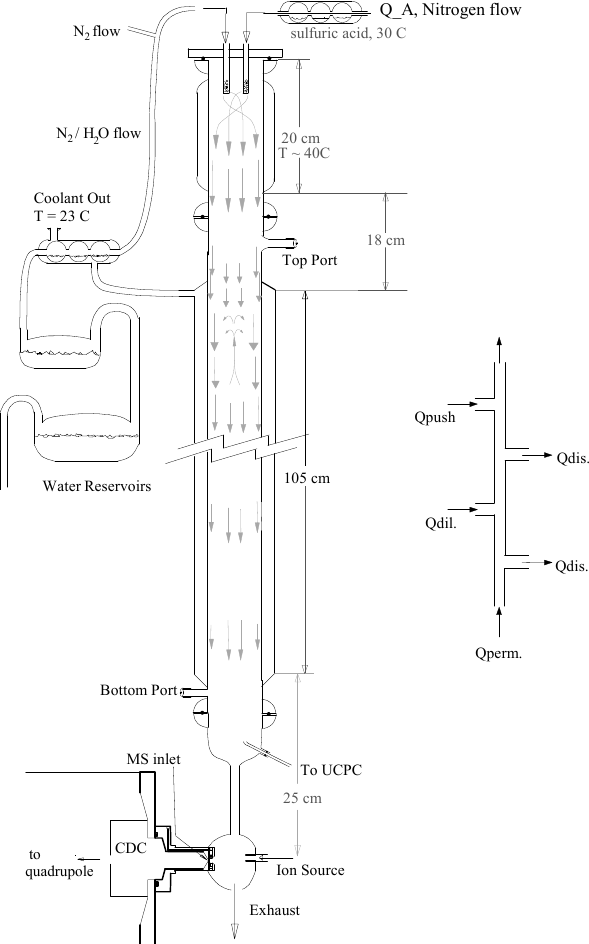
Fig. 1. Schematic drawing of the nucleation flow reactor with mix- ing region, transition and nucleation regions indicated. Water and H 2 SO 4 sources (i.e., the reservoirs), the general flow patterns and temperatures are indicated. Top and bottom ports show where N bases could be added to the flow. The region of highest particle for- mation rates within the nucleation region are about 30cm into the cooled region. The dynamic dilution system for adding N bases is shown to the